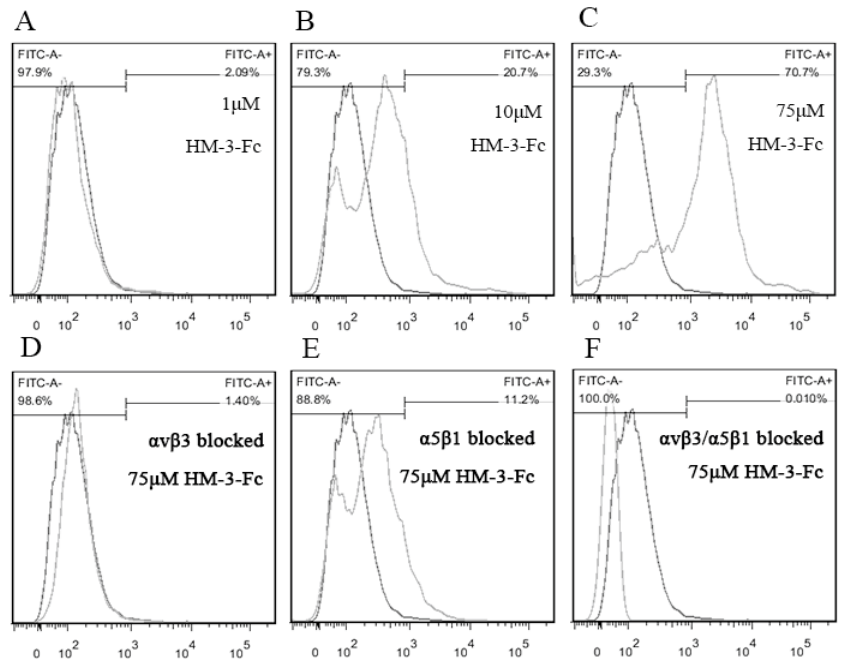
Figure 3. Specific and high affinity binding of HM-3-Fc with integrin α v β 3 and α 5 β 1. A flow cytometry method was setup with FITC-protein A (FITC-A) as a probe that binds the Fc part of HM-3-Fc. The dark line indicated the fluorescence signal for untreated synovial cells and it was used to define the threshold of positive fluorescence signal. The light line indicated the fluorescence signal for HM-3-Fc and FITC-A treated synovial cells. ( A – C ) The binding rates of synovial cells after incubation with 1, 10 or 75 µ M HM-3-Fc before incubated with FITC-A. ( D – F ) The binding rates of synovial cells that were blocked with anti- α v β 3, anti- α 5 β 1, or their combination.